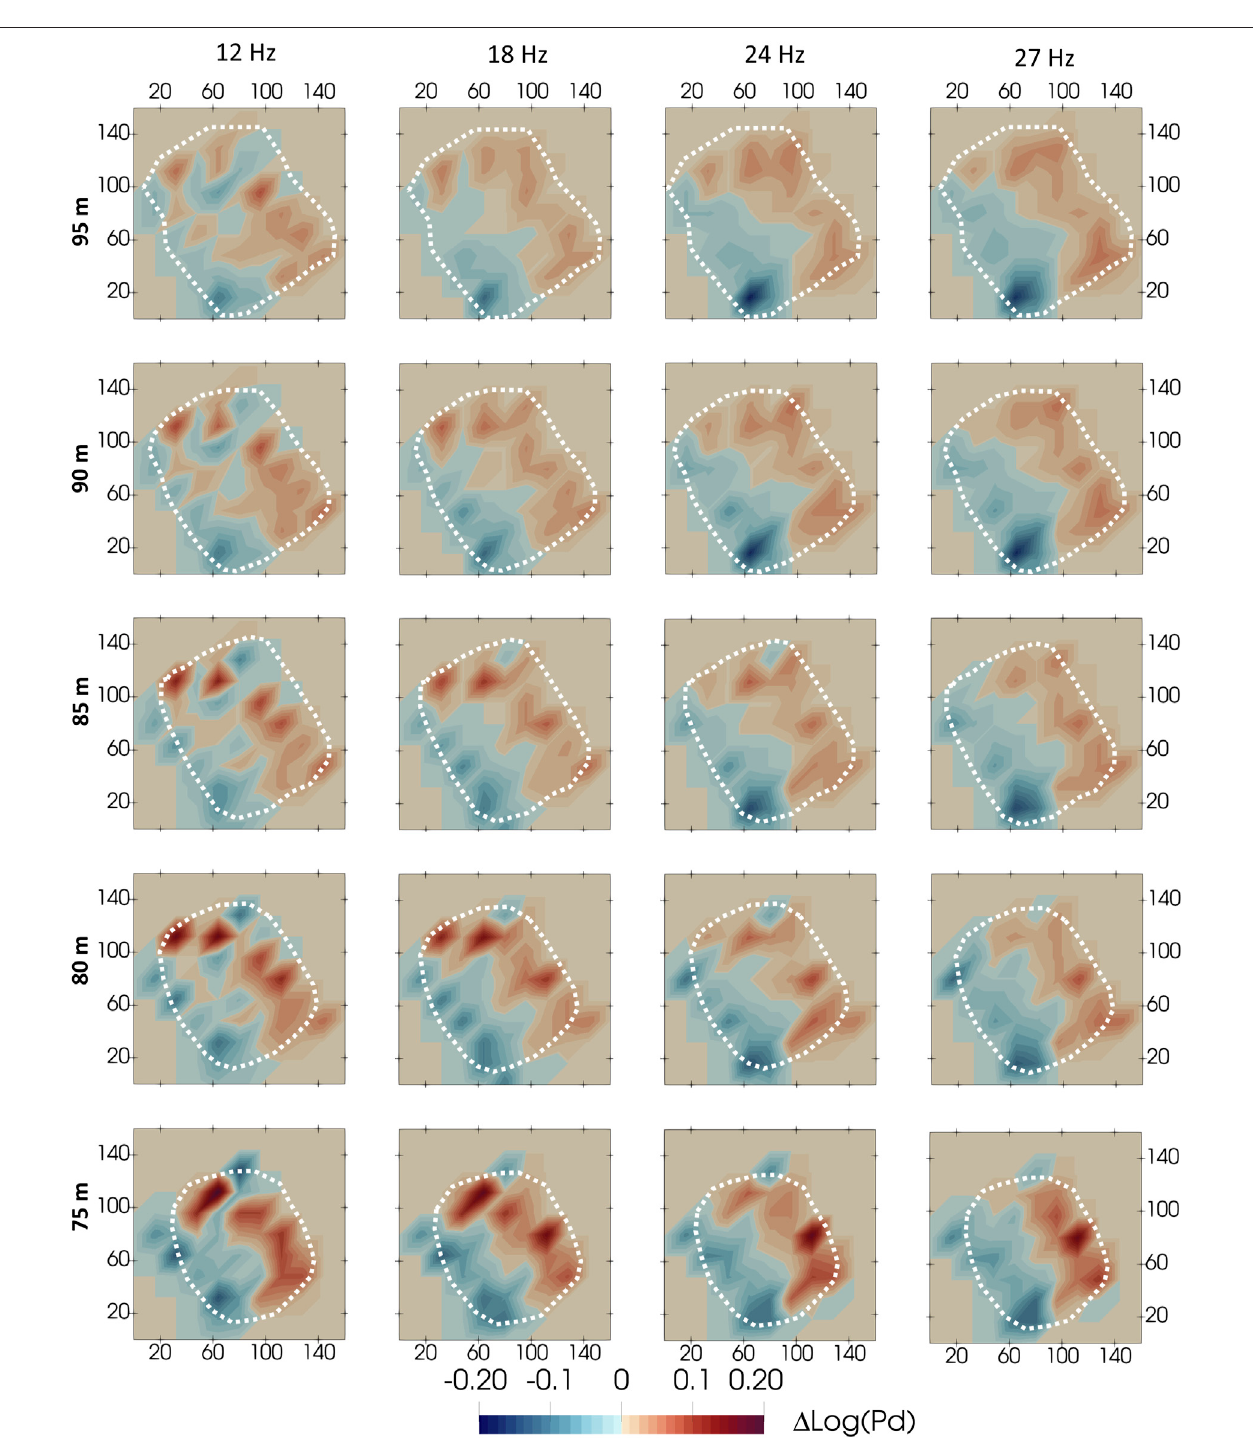
FIGURE 6 | Peak delay variations at different frequencies. The white dashed polygon represents the resolution limits of the retrieved models based on the ray crossing.